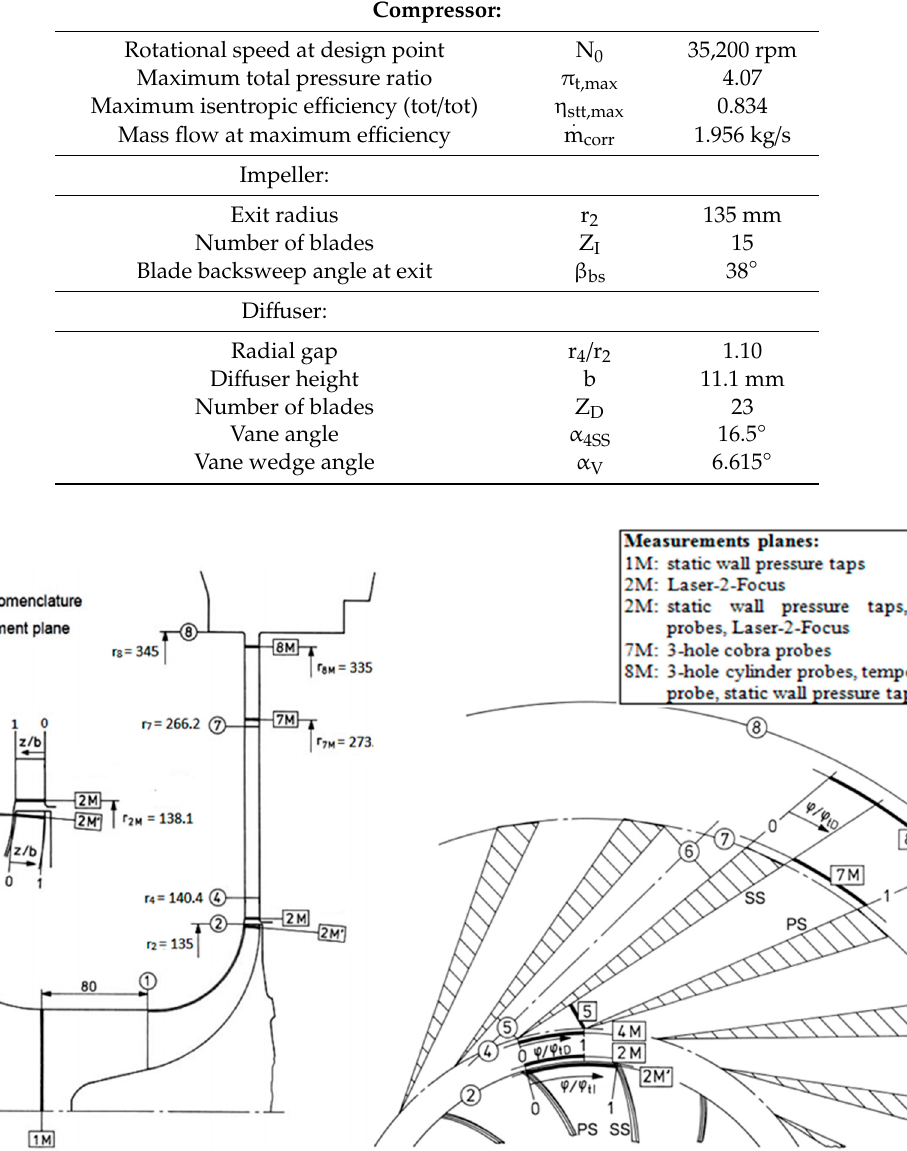
Figure 1. Measurement planes in meridional (left) and blade to blade (right) view (Ziegler, 2002a) [23]. Dimensions are in [mm] and referred to the configuration [ α 4SS = 16.5°, r 4 /r 2 = 1.04].